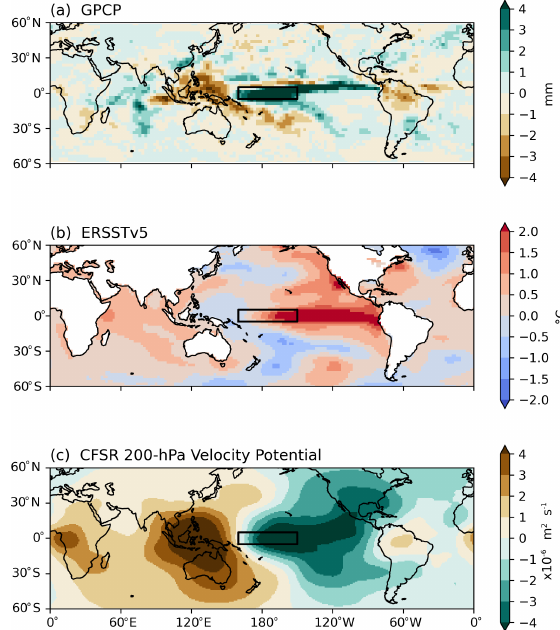
Figure 6. Anomalies of GPCP precipitation, ERSSTv5 SST, and CFSR 200hPa velocity potential during the peak 6 months of the 2015–2016 El Niño event. The box shows the Niño 4 domain in the central Pacific (5 ◦ S–5 ◦ N, 160 ◦ E–150 ◦